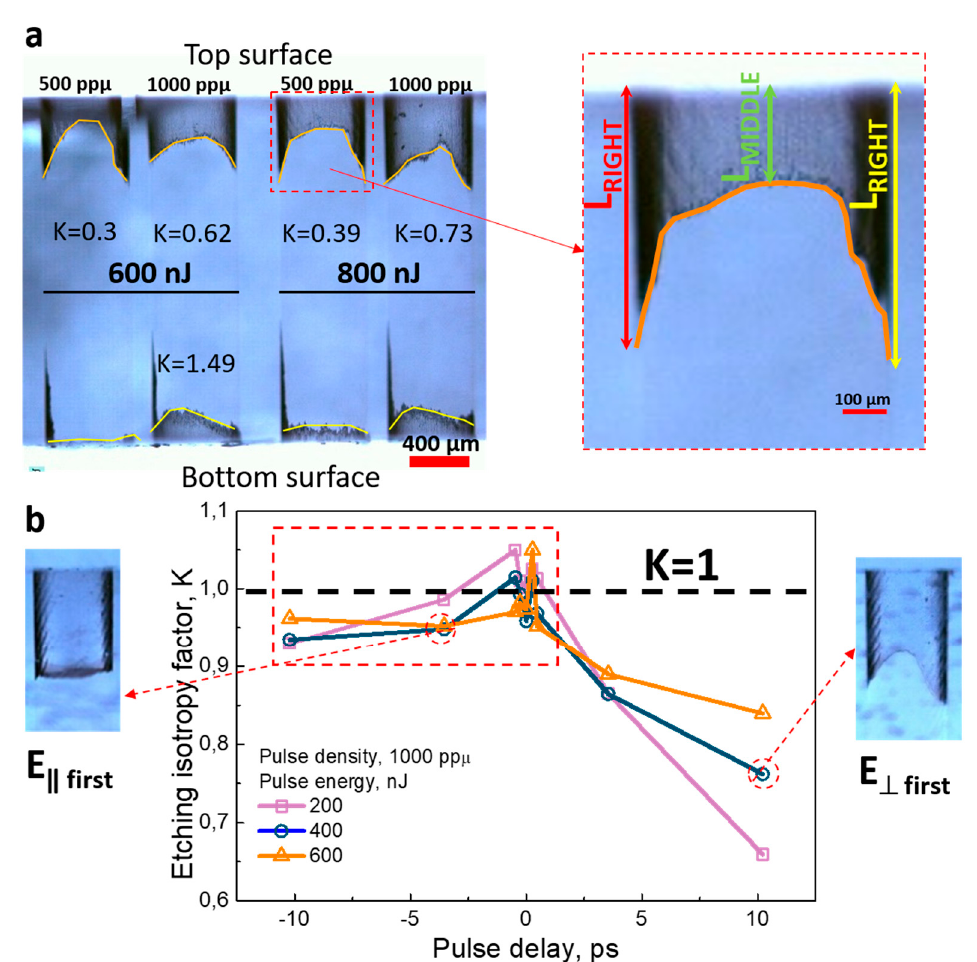
Figure 8. Etching of bow-like structures fabricated with the single-pulse regime at 600 nJ and 800 nJ pulse energy ( a ) and dependence of the etching isotropy factor K on the pulse delay for etching from the top sample surface of the vertical surface. ( b ). The insets show the microscope pictures with etched vertical surfaces.